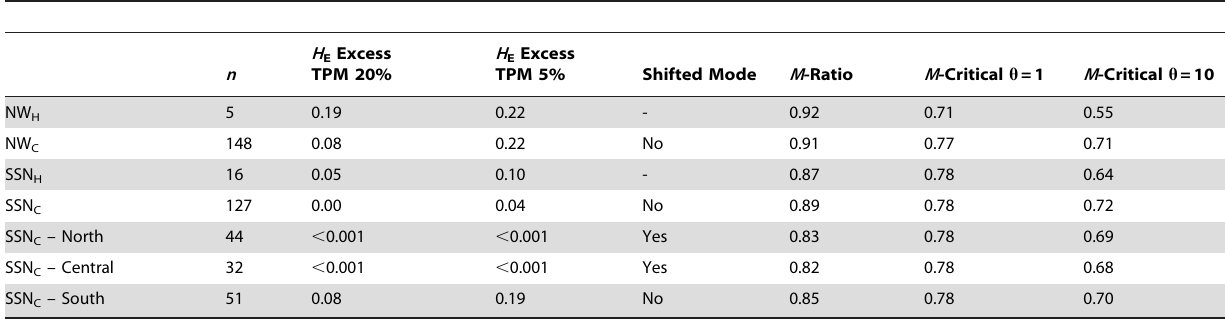
Table 3. Results of BOTTLENECK tests including the p values for the Wilcoxon heterozygosity ( H E ) excess test with two different proportions of multistep mutations in the two phase model (TPM), shifted mode test, and M -Ratio value and M -Critical values.